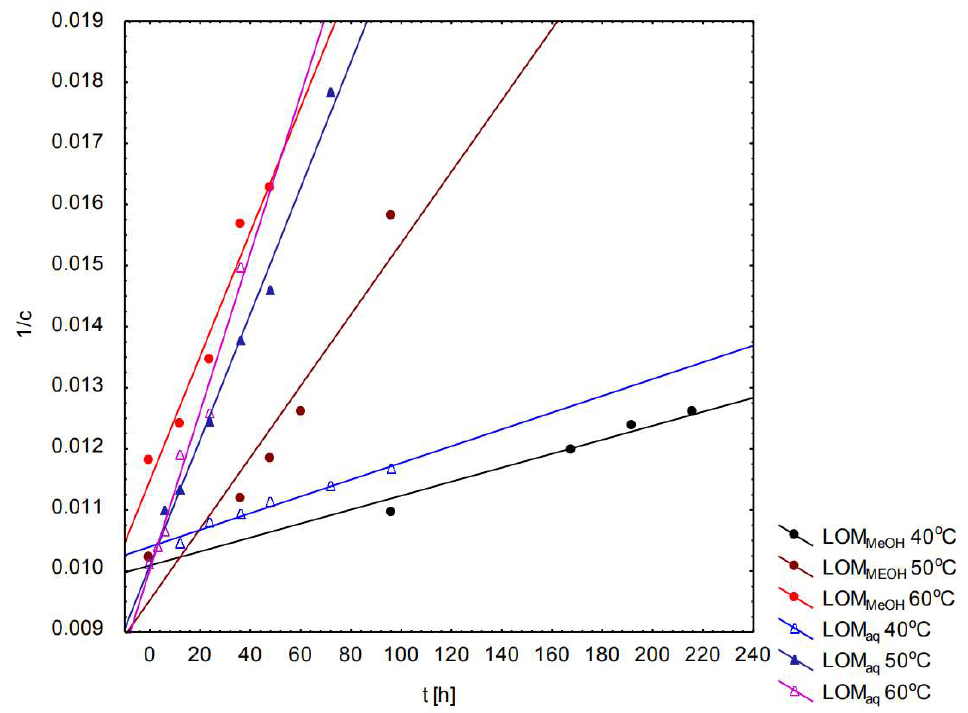
Figure 10. The 1 / c = f(t) graph of oxidation of aqueous and methanolic LOM solutions under the Figure 10. The 1/c = f(t) graph of oxidation of aqueous and methanolic LOM solutions under the influence of ACVA. Molecules 2020 , 25 , x FOR PEER REVIEW 11 of 24 influence of ACVA.